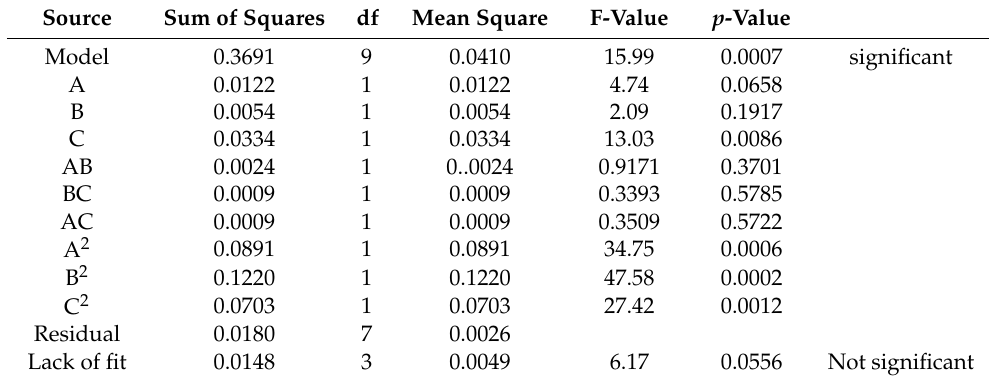
Table 5. ANOVA statistics of the quadratic model for the extraction yields of UA.